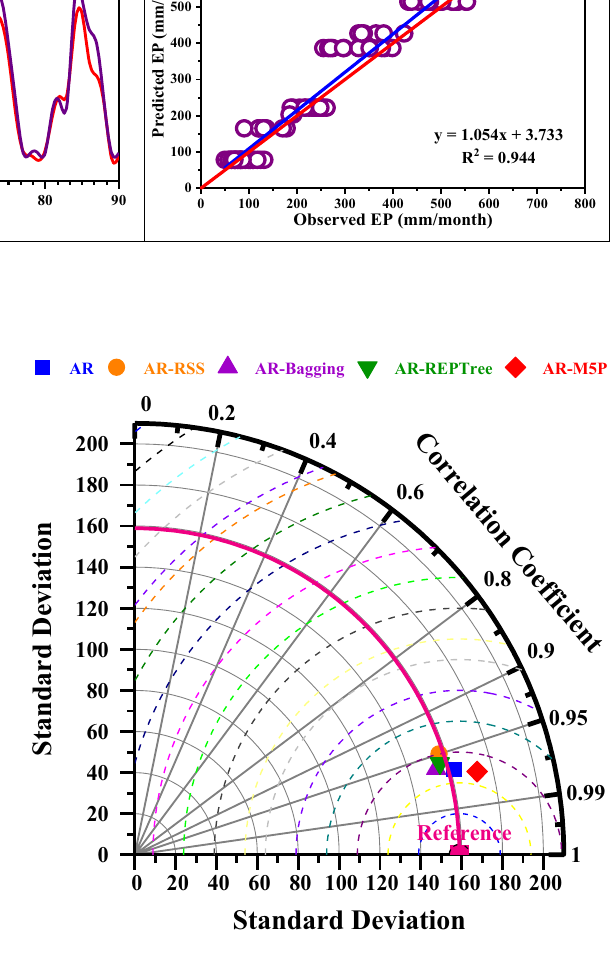
Fig. 7 Taylor diagrams of AR, AR-RSS, AR-Bagging, AR-REPTree, and AR-M5P during testing span at Baghdad